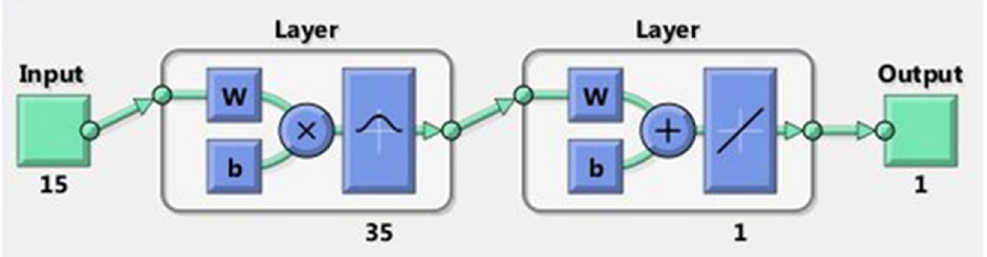
Figure 3. The best structure of RBFNN model (MATLAB R2013b, http://www.mathw orks.com).